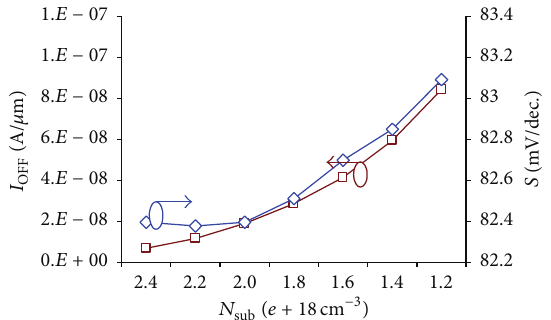
Figure 10: 𝐼 OFF as function of channel doping.